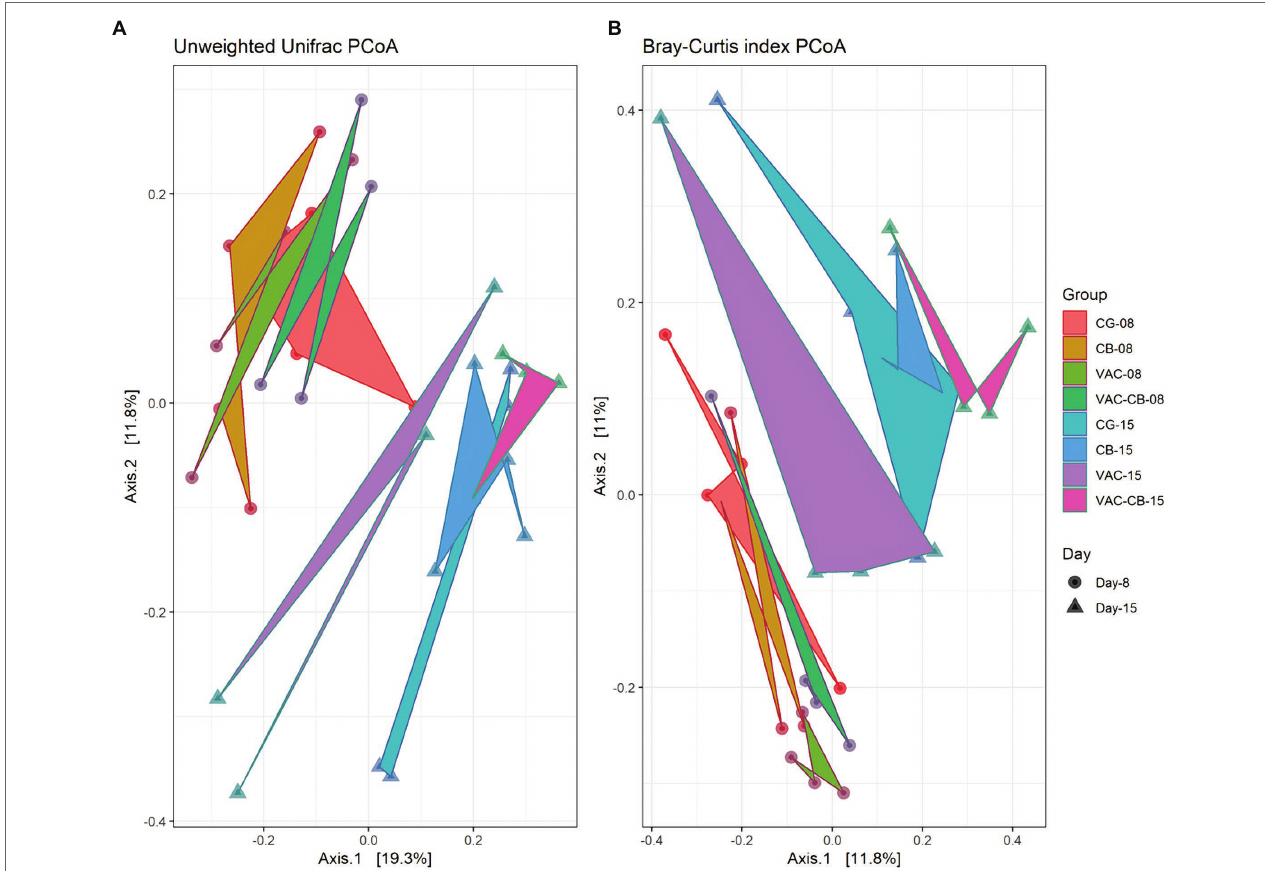
FIGURE 4 | Beta diversity assessment of the intestine microbiome in various pretreatment groups at 8 and 15 days old. Three-dimensional scatter plots were generated using principal coordinates analysis (PCoA). PCoA was performed using ordinate function, and plots were drawn using the plot_ordination function from the phyloseq package. Distances shown in the PCoA plot are based on unweighted UniFrac distances (A) and Bray–Curtis diversity metrics (B) , respectively. The bacterial microbiome of each sample is indicated with one dot. The different color blocks represent different experimental groups. The different traits of the dots represent the different ages of the experimental